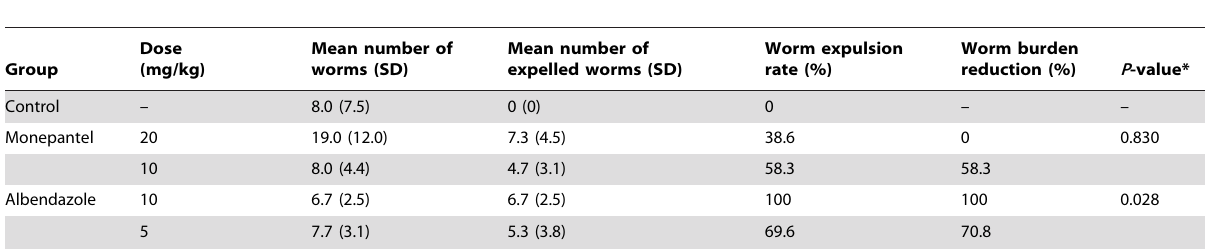
Table 4. Effects of monepantel and albendazole on N. americanus in vivo .